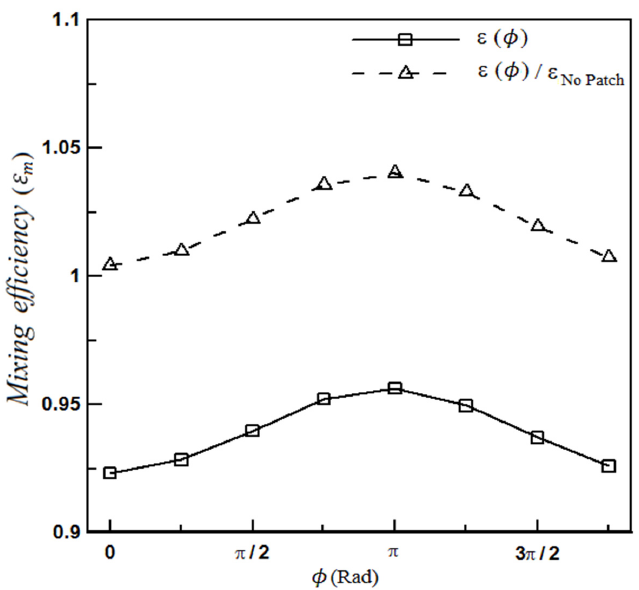
Figure 6. Relative and absolute mixing efficiency of microchannel for the flow fields of Relations (20) and